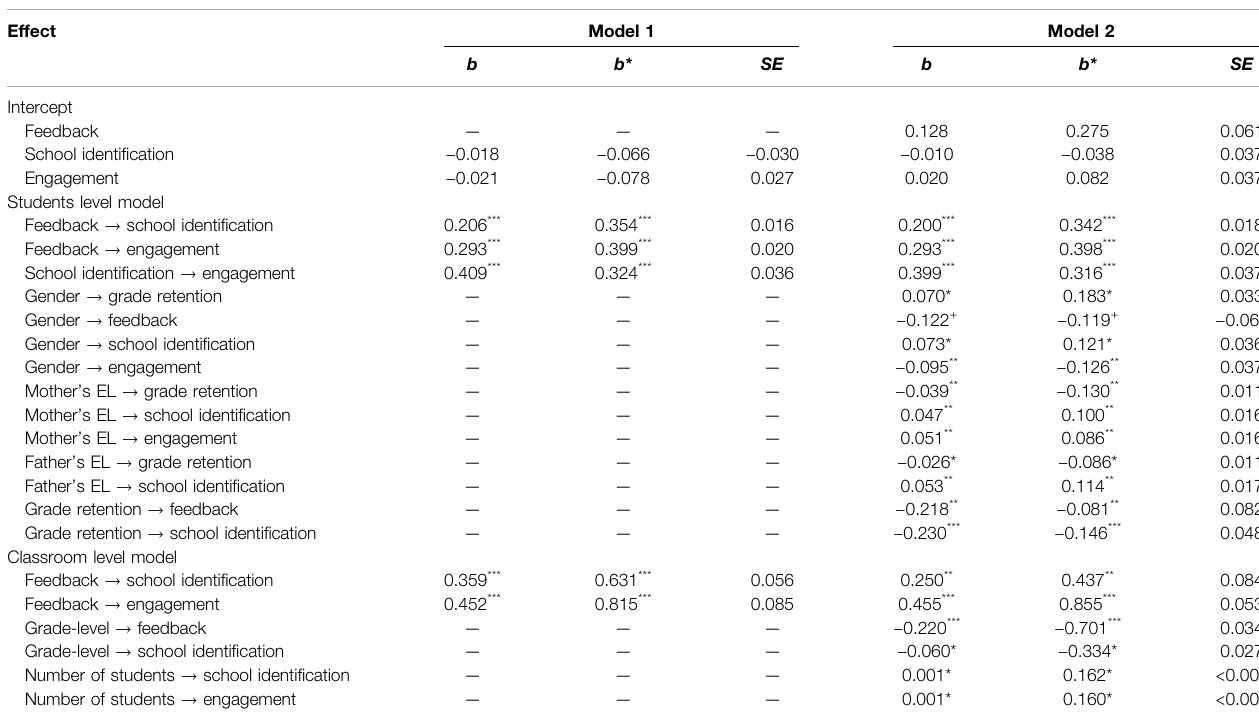
TABLE 3 | Coef fi cients of the multilevel models tested. Effect